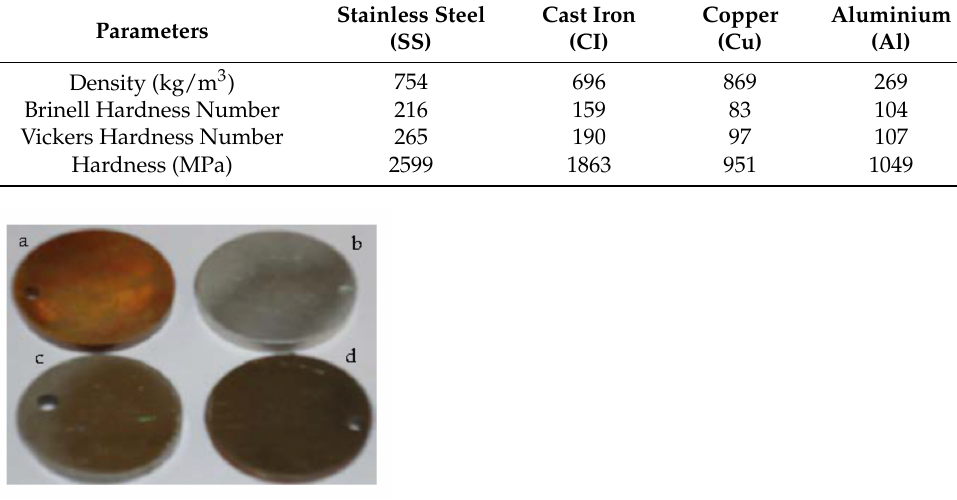
Figure 1. Photograph of different metal samples (( a ): Cu; ( b ): Al; ( c ): SS; ( d ): CI) after the immersion